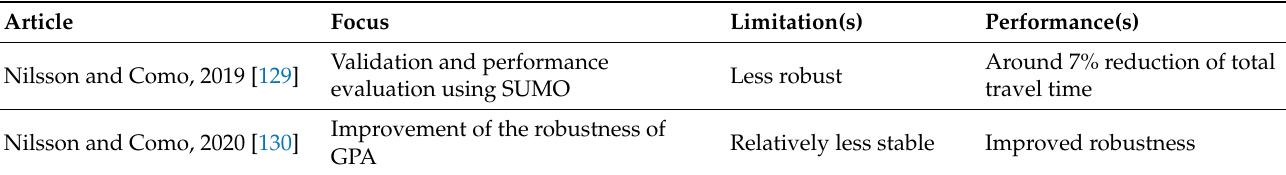
Table 22. Summary of the works found related to